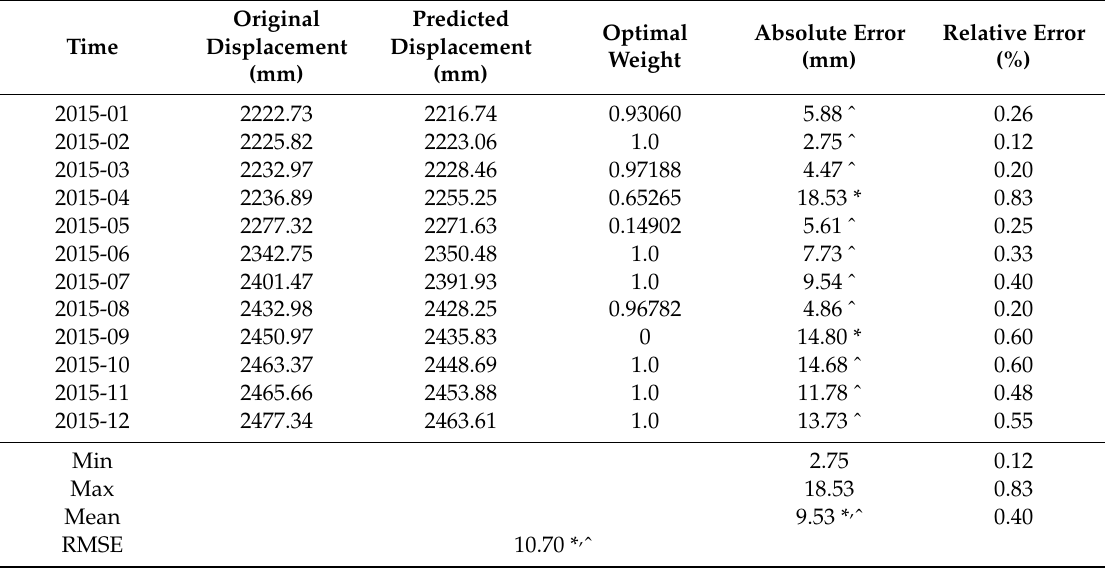
Table 9. Accuracy of the predicted displacement with the LSTM and SVR models of ZK2-3.